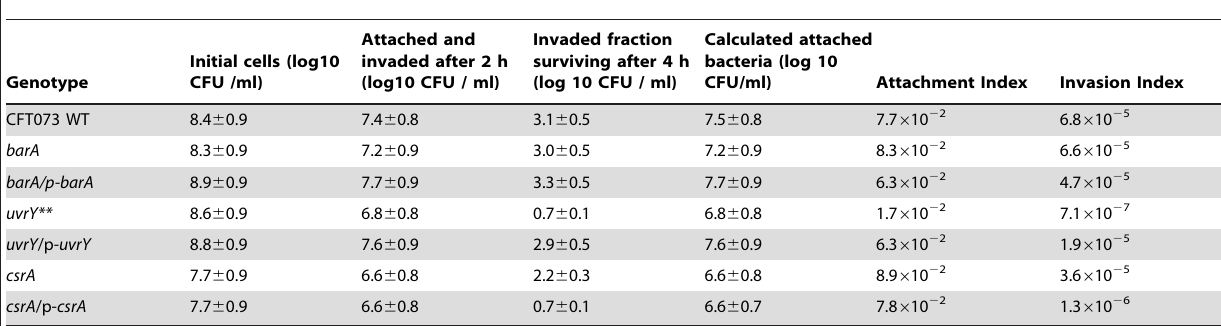
Table 3. Mutation in uvrY reduces invasion of E. coli CFT073 strain to ureter (SV-HUC-1) uroepithelial cells.